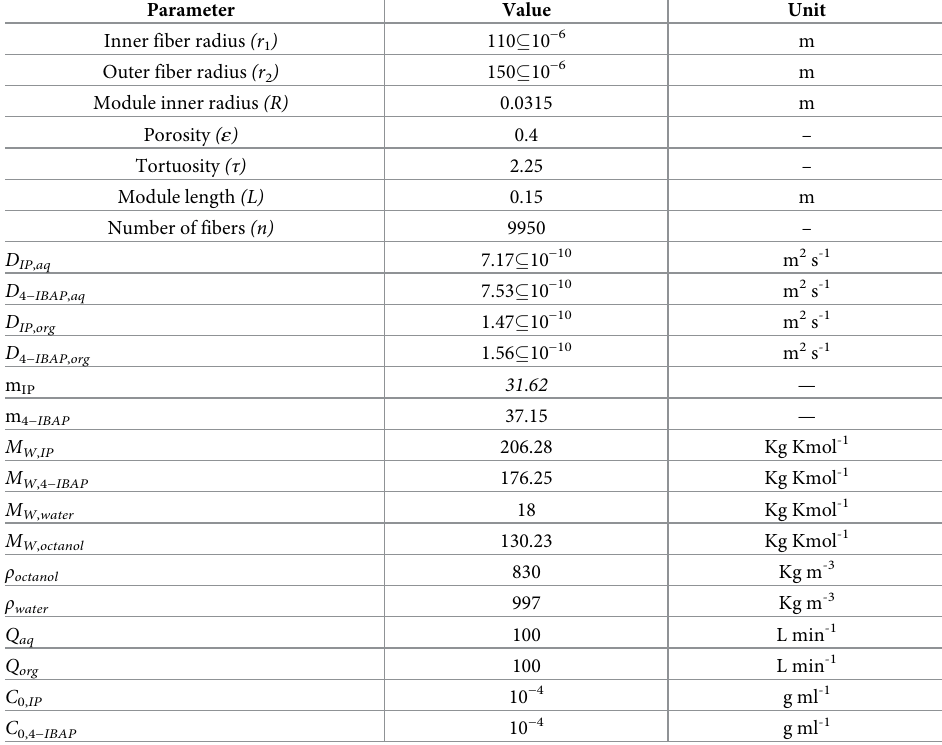
Table 2. The PMC’s specifications and physicochemical parameters used for modeling